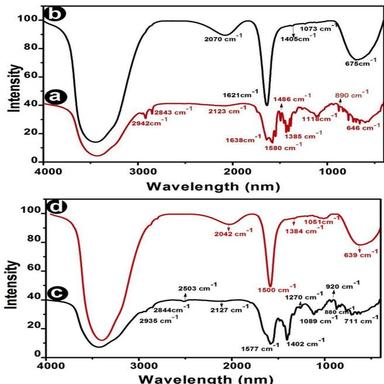
FT-IR spectra of the wastewater samples for (a) P1WW; (b) P1WT; (c) P2WW and (d) P2WT.